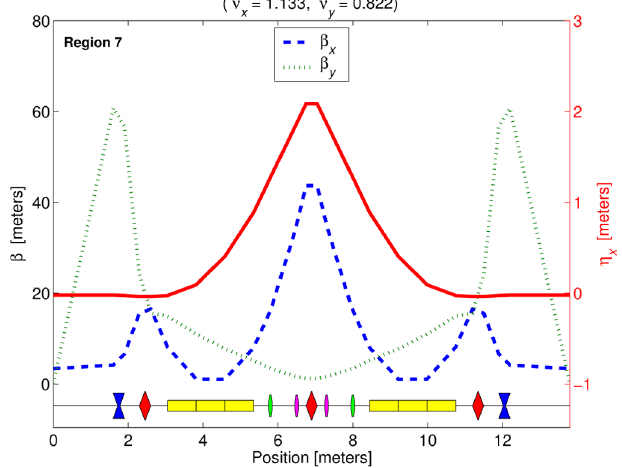
FIG. 17. (Color) Lattice functions for a CAMD DBA sector in region 7. The polarities of the QF and QD magnets are reversed. This example was chosen to illustrate an achromat with rela- tively small